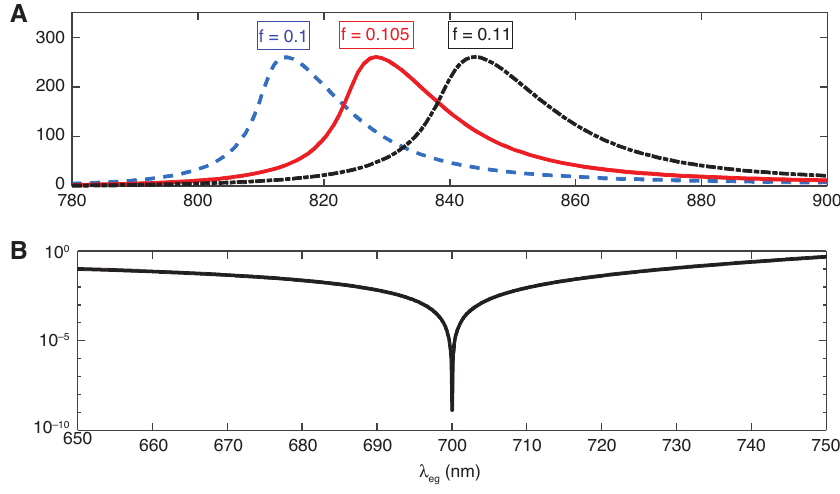
Figure 3: Analytical results. (A) Enhancement and (B) suppression of the SERS signal due to path interference effects. Presence of an aux QE, of level spacing ω can lead to (A) cancellation or (B) growth in the denominator of the SERS response, in Eq.